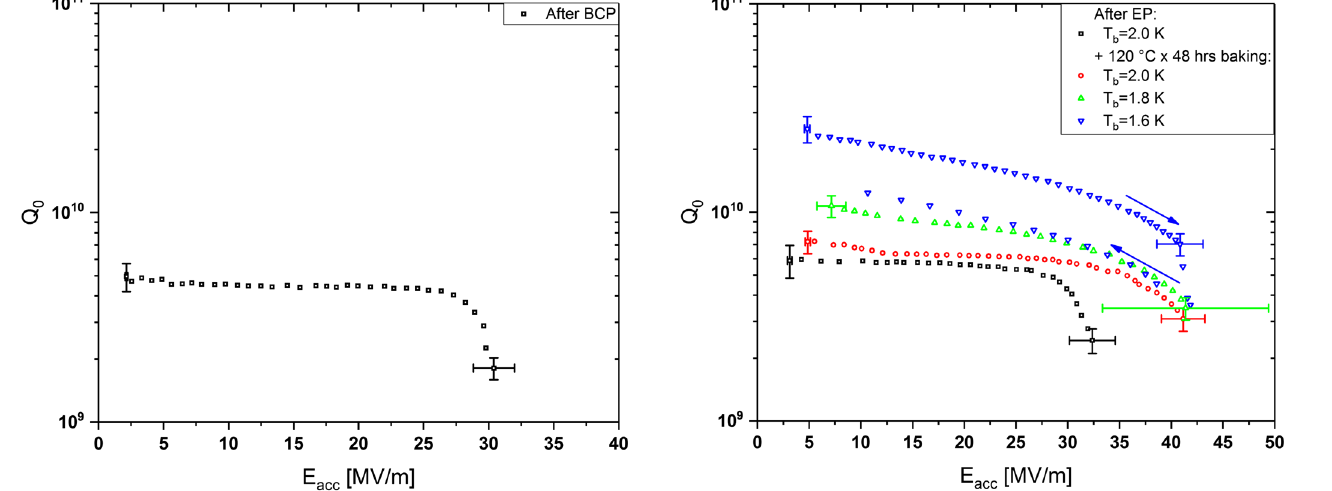
FIG. 4. FH3E test results at T b ¼ 2 . 0 K. Note the characteristic high-field degradation.